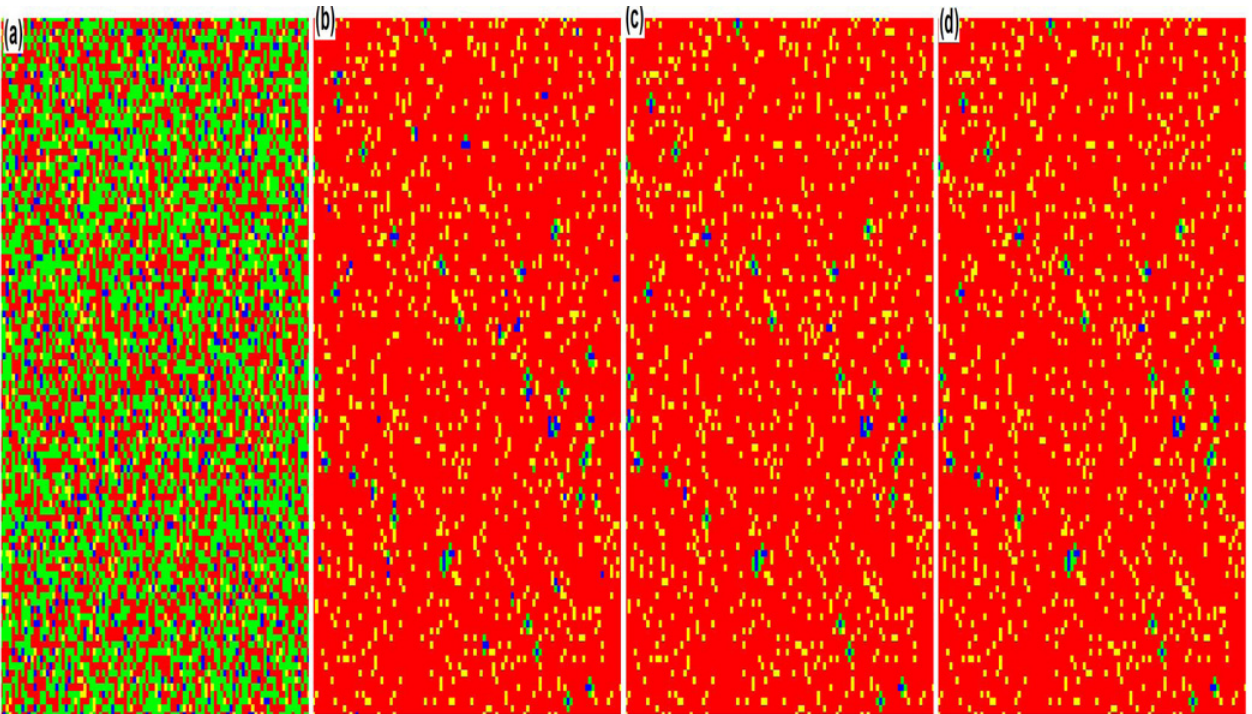
Fig 2. Direct observations of behavioral evolution for the whole population when f = 0.1 and q = 1. Snapshots are taken at t = 1, 3, 100 and 500 MC steps. In the figure blue, yellow, green and red are used to represent behavior 1 in group 1, behavior 2 in group 1, behavior 1 in group 2 and behavior 2 in group 2 respectively. The game parameters in the numerical simulation are set as [ B 1 , B 2 , B 3 , B 4 , C 1 , C 2 , C 3 , C 4 ] = [2, 2, – 1, – 1, 1, 1, 2,